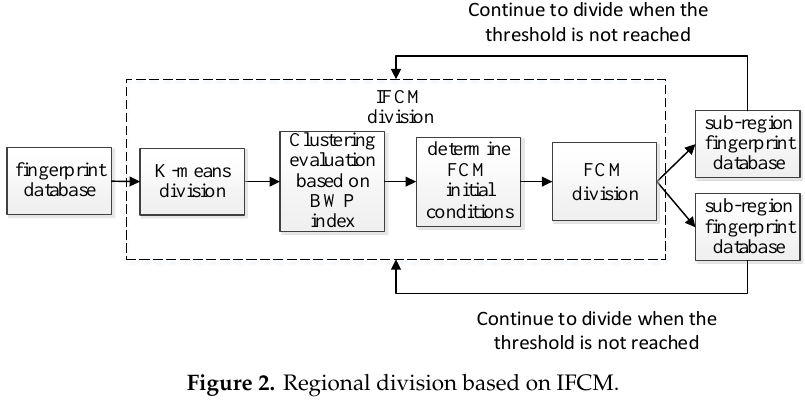
Figure 2. Regional division based on IFCM.